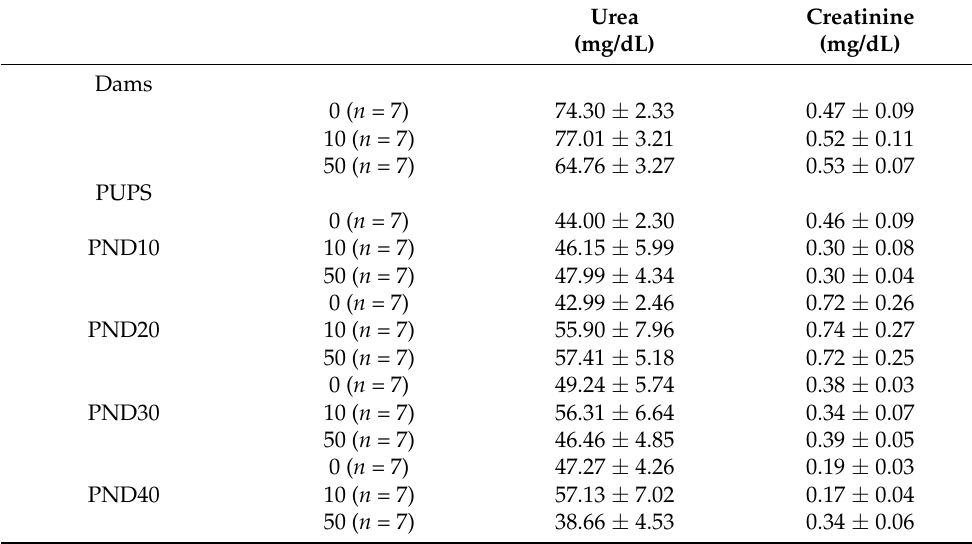
Table 4. Serum urea and creatinine levels from dams and pups exposed to different doses (0, 10, and 50 µ g Hg 2+ /mL) of HgCl 2 as described in Tables 1 and 3,